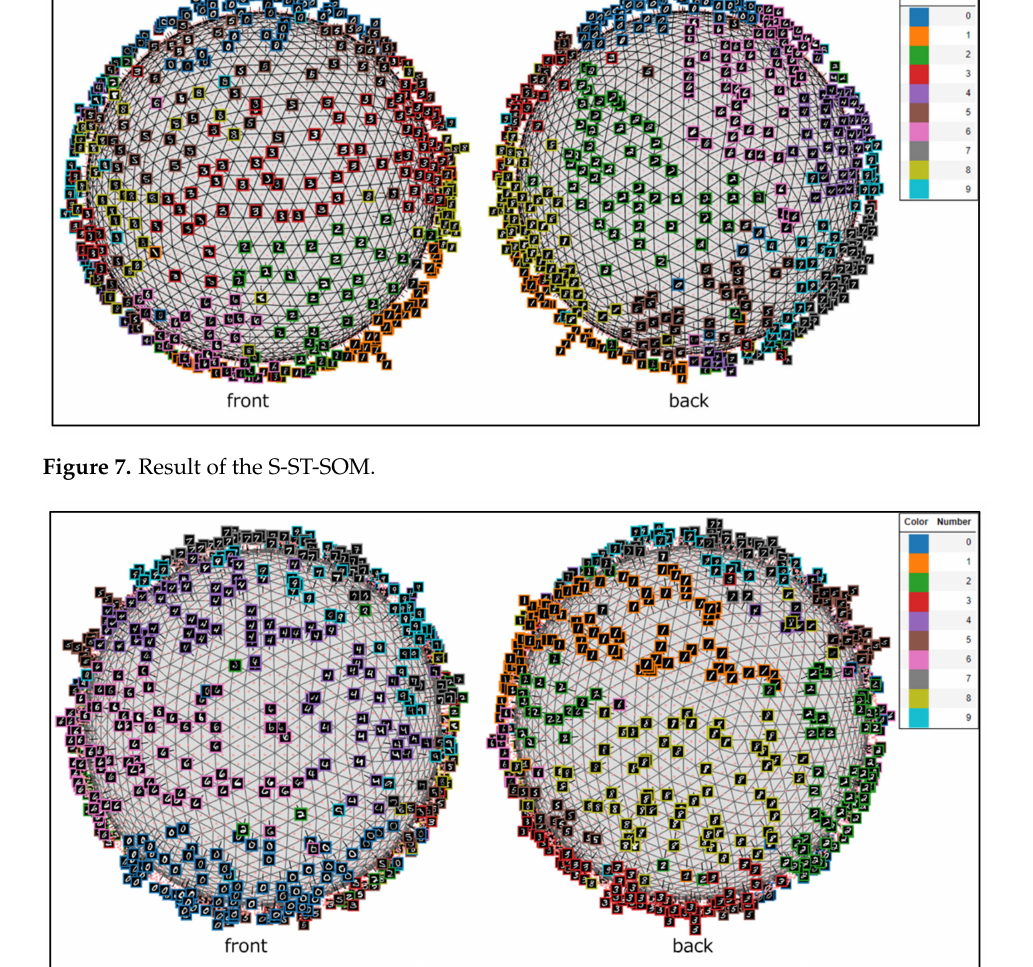
Figure 8. Result of the